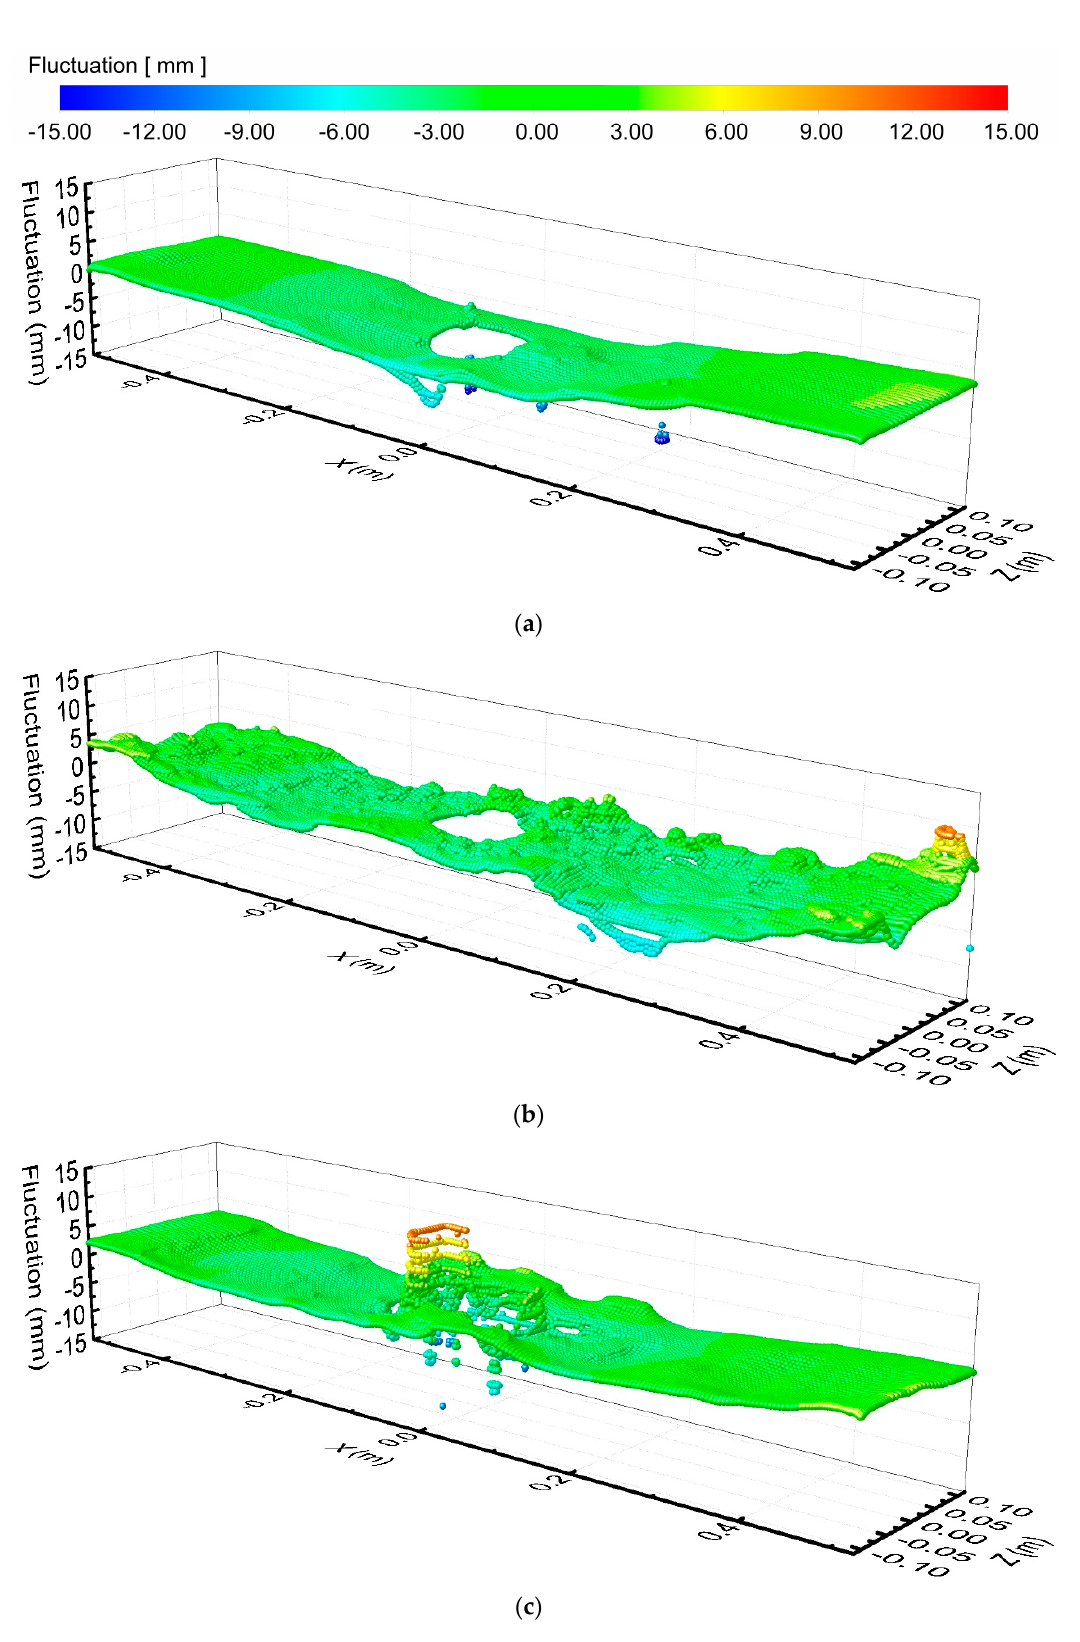
Figure 11. Fluctuation diagram of mold surface under EMBr Mode 3 and at different argon flow rates of: ( a ) 0 L·min − 1 , ( b ) 6 L·min − 1 , ( c ) 10 L·min − 1 .